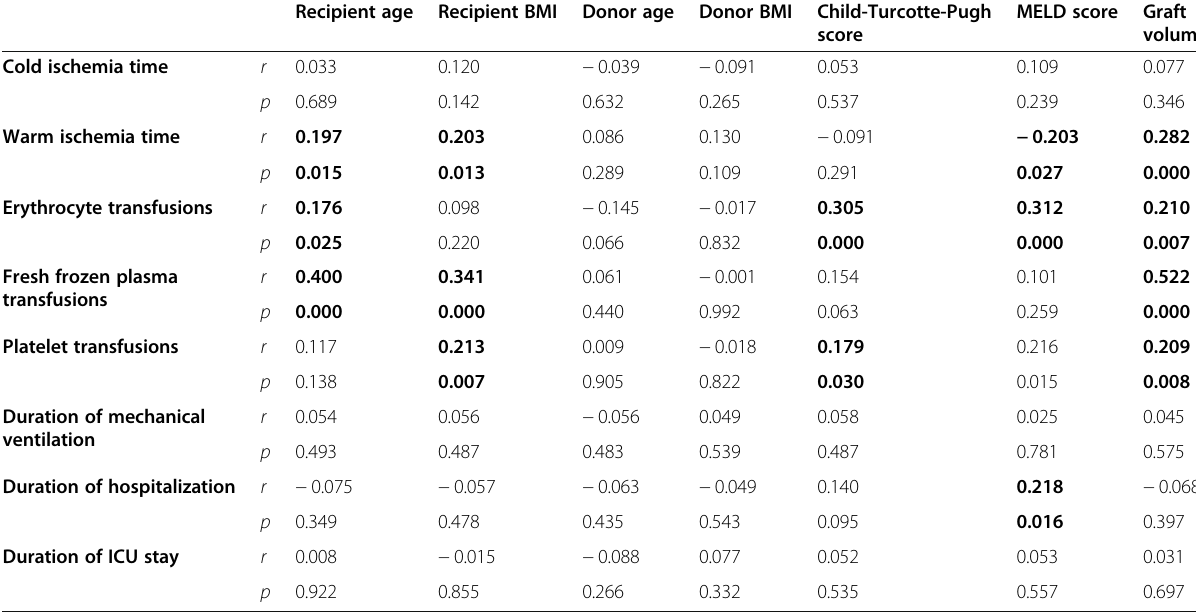
Table 5 Correlation analyses between the patient characteristics and clinical